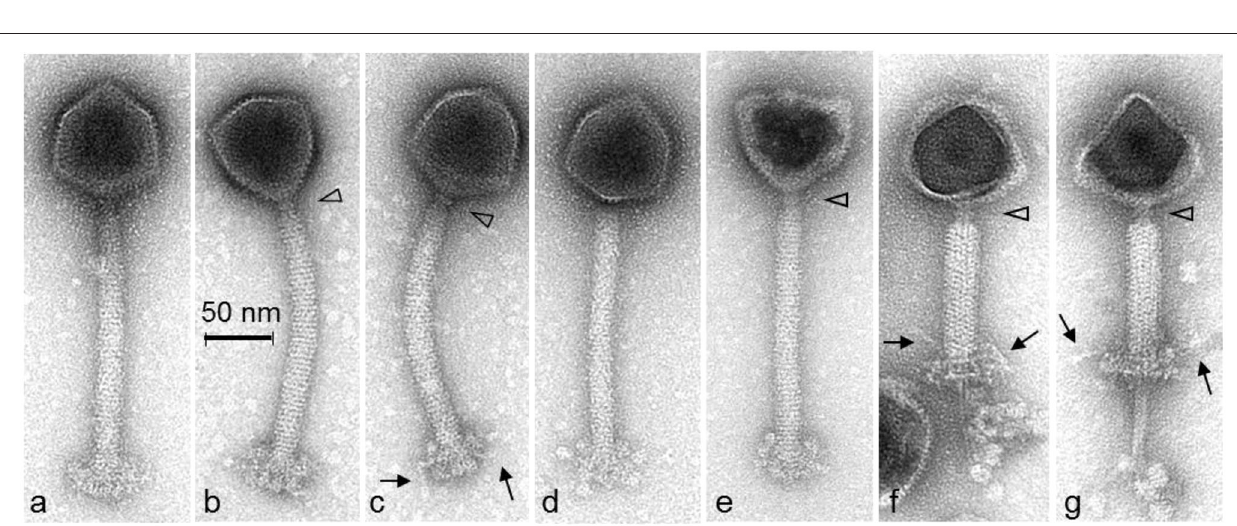
FIGURE 2 | Transmission electron micrographs of L. monocytogenes phage P61 stained with 1% (w/v) uranyl acetate. The open triangles indicate the thin collar structure beneath the capsids. The blackberry-like surface structure of the capsid surface is visible on intact phage particles (a–d) . The arrows show thin tail fibers extending from the upper region of the baseplate structure of intact (c) or contracted phage particles (f,g) . The double disc structure of the baseplate is visible on phage particles with contracted tail sheaths and damaged capsids (f,g) . The baseplate appendages seem to be highly flexible with a brush-like appearance (a,b) or forming globular structures (d,e)